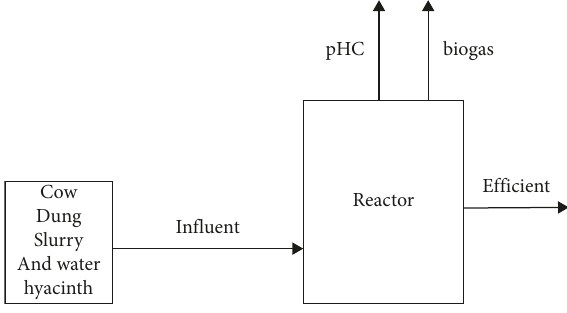
Figure 1: Production of biogas in our